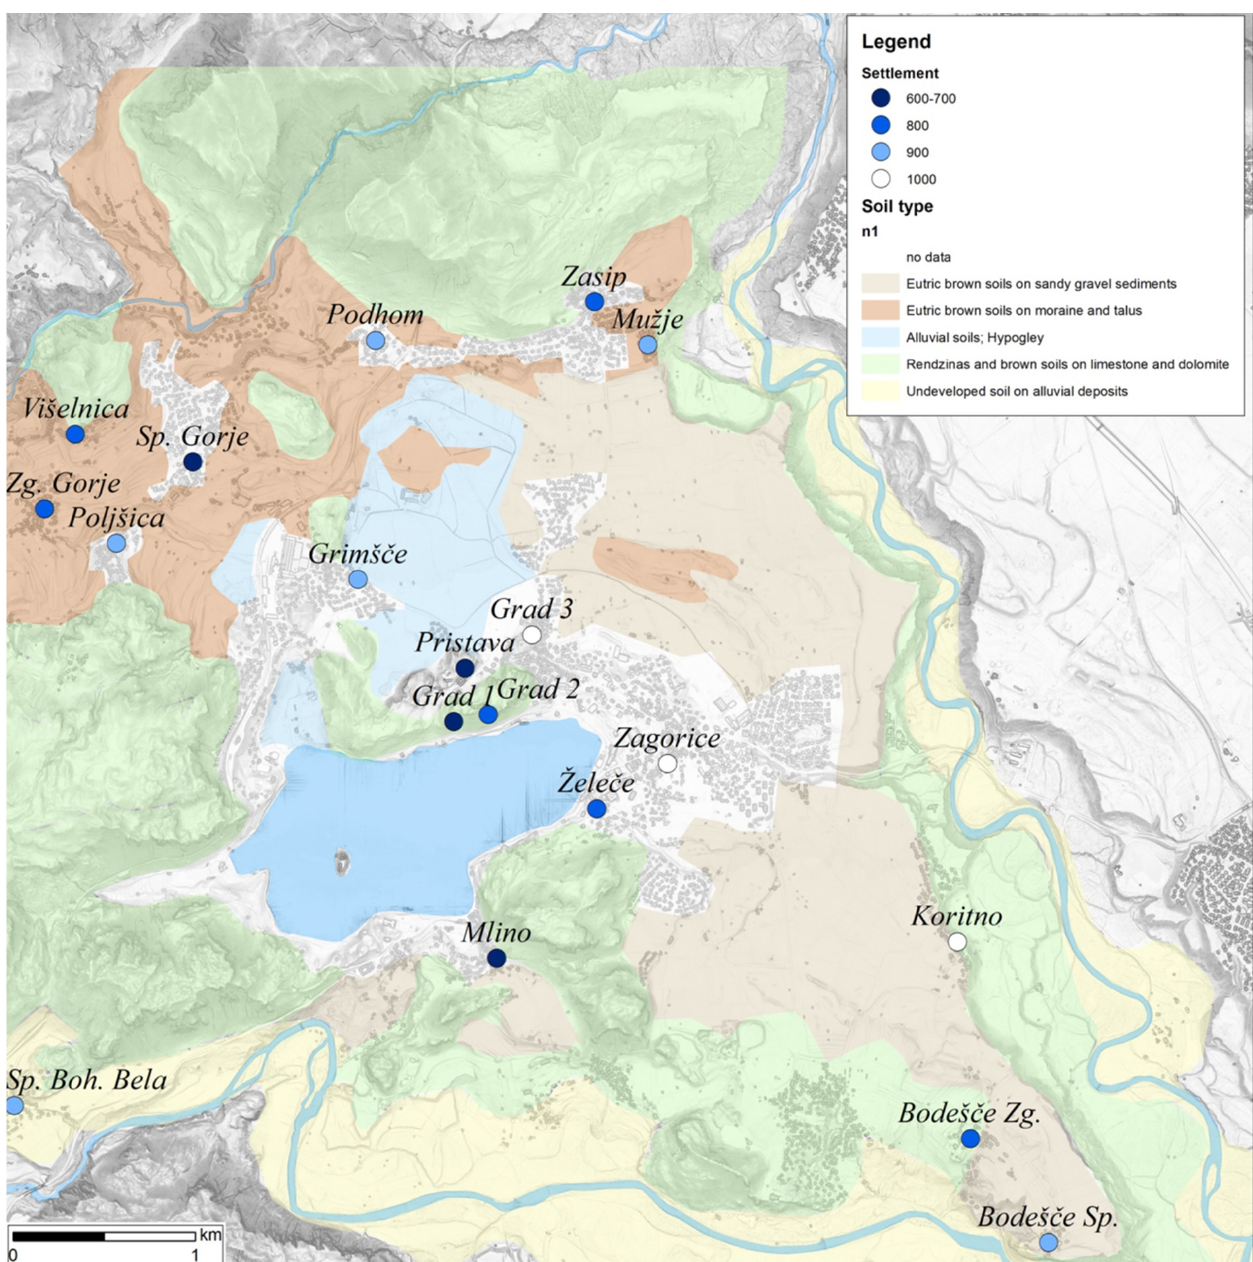
Figure A3. Bled micro-region (decimal longitude and latitude coordinates of the map centre: 14.1139; 46.3752), soil map (source data adopted from [94]; North at the top).